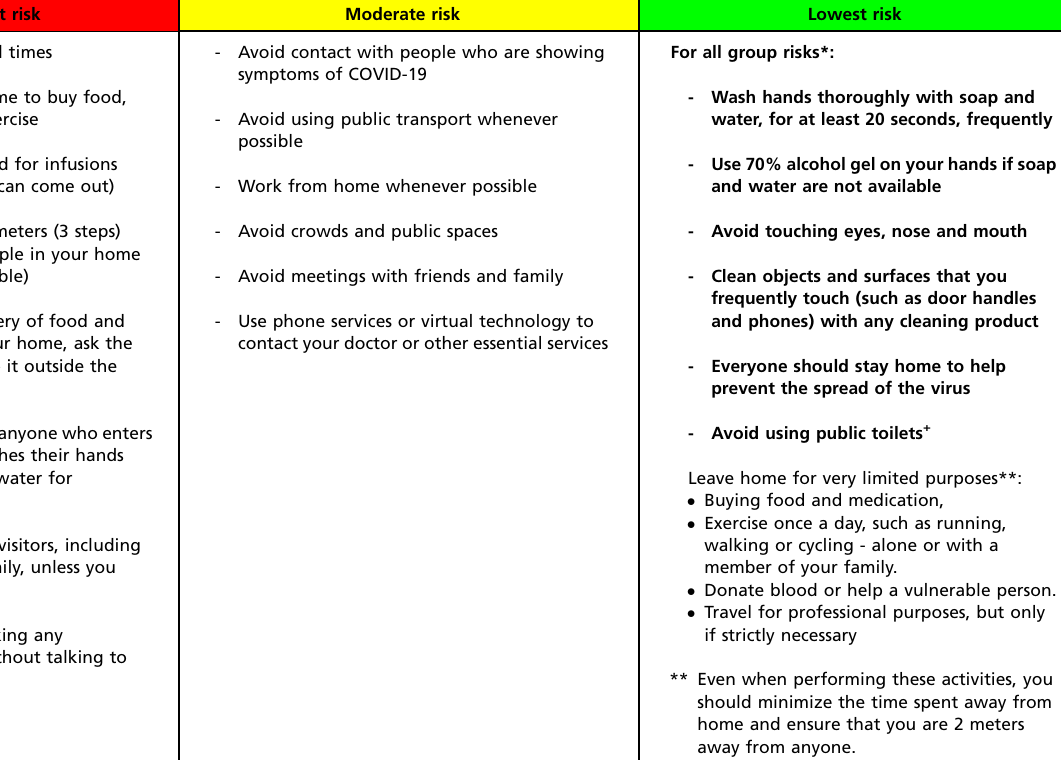
Table 1 - Recommendations for IBD patients according to their risk level. Highest